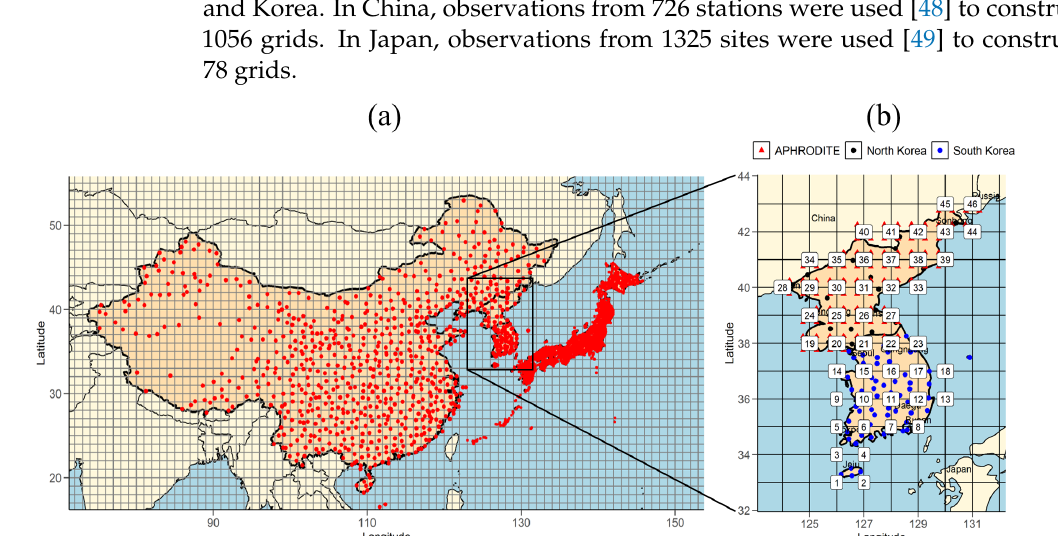
Figure 1. ( a ) Map of East Asia showing the observations sites and grid points. The Barnes interpolation method was employed to re-grid and to construct a rainfall field over 1 ◦ × 1 ◦ grids of 1180 points over East Asia. ( b ) Map of the Korean peninsula from 123 ◦ to 132 ◦ longitude and 33 ◦ to 43 ◦ latitude, including the sea and land, with 46 grid points of 1 ◦ × 1 ◦ for this